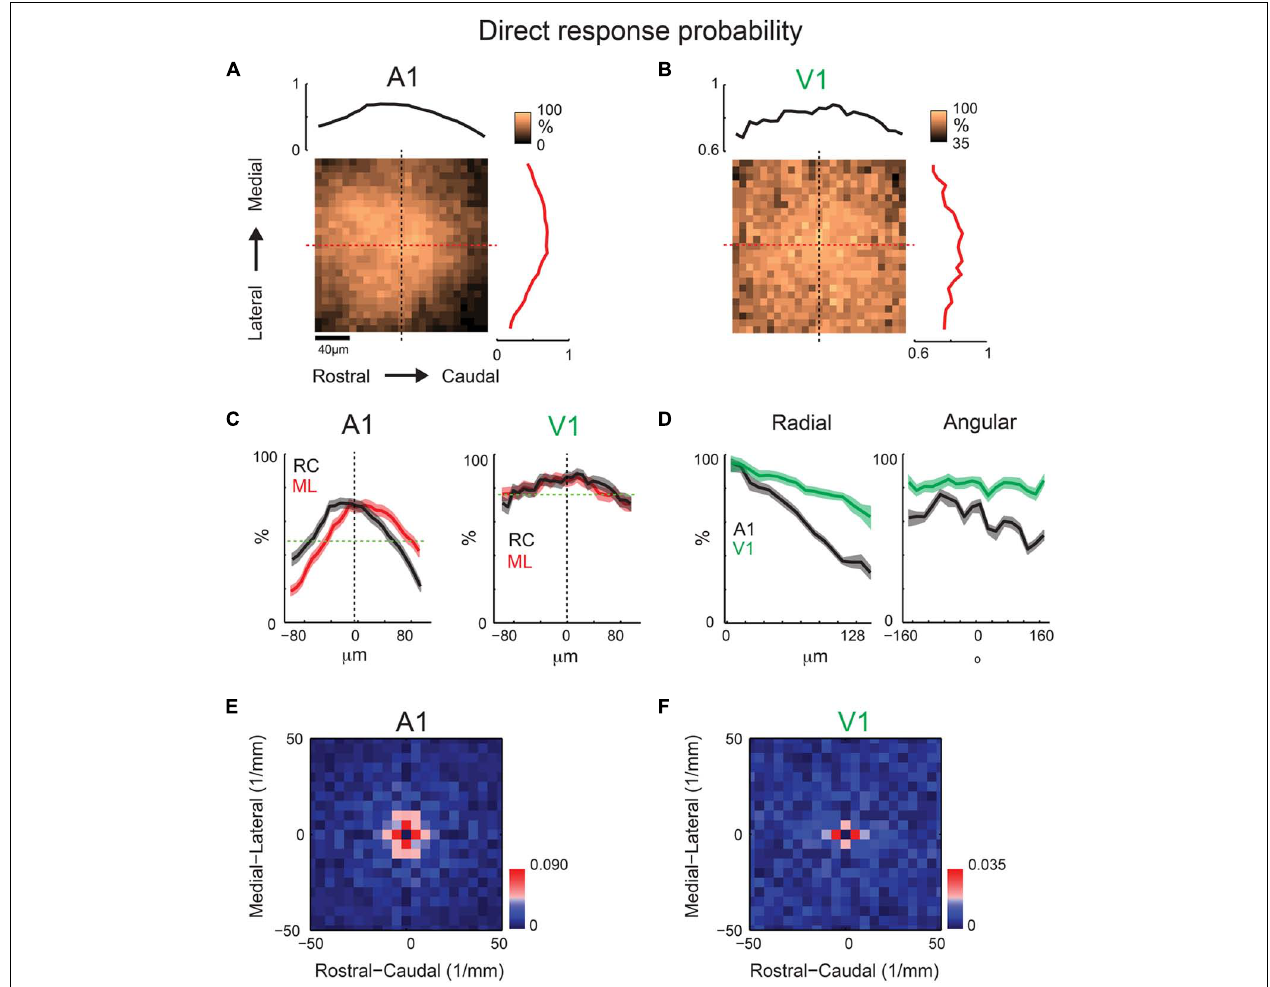
FIGURE 9 | Mean direct probability maps from a population of neurons recorded at 40 × reveal spatially periodic dendritic structure. Mean maps from a population of A1 ( A ; N = 33) andV1 ( B ; N = 20) recorded neurons demonstrating relatively symmetric profile of basal dendrites in both A1 and V1. Plots above and to the right of the mean map indicate the marginal profile along the ML (isofrequency) and RC (tonotopic) directions, respectively. (C) Overlaid ML and RC marginals from (A,B) for A1 (left) andV1 (right). Green dashed line indicates the mean of the shuffled image and the black dashed line indicates cell-center.The shaded areas for this and subsequent plots